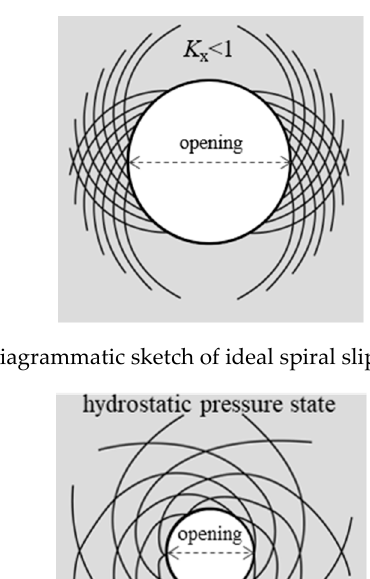
Figure 11. Effect of various coefficients of lateral pressure on EDZs.